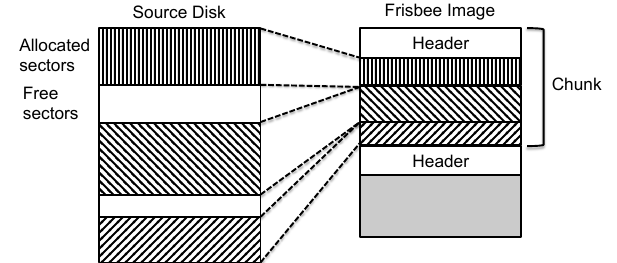
Figure 1: Frisbee identifies allocated disk sectors, compresses them, and concatenates them into 1MB chunks.